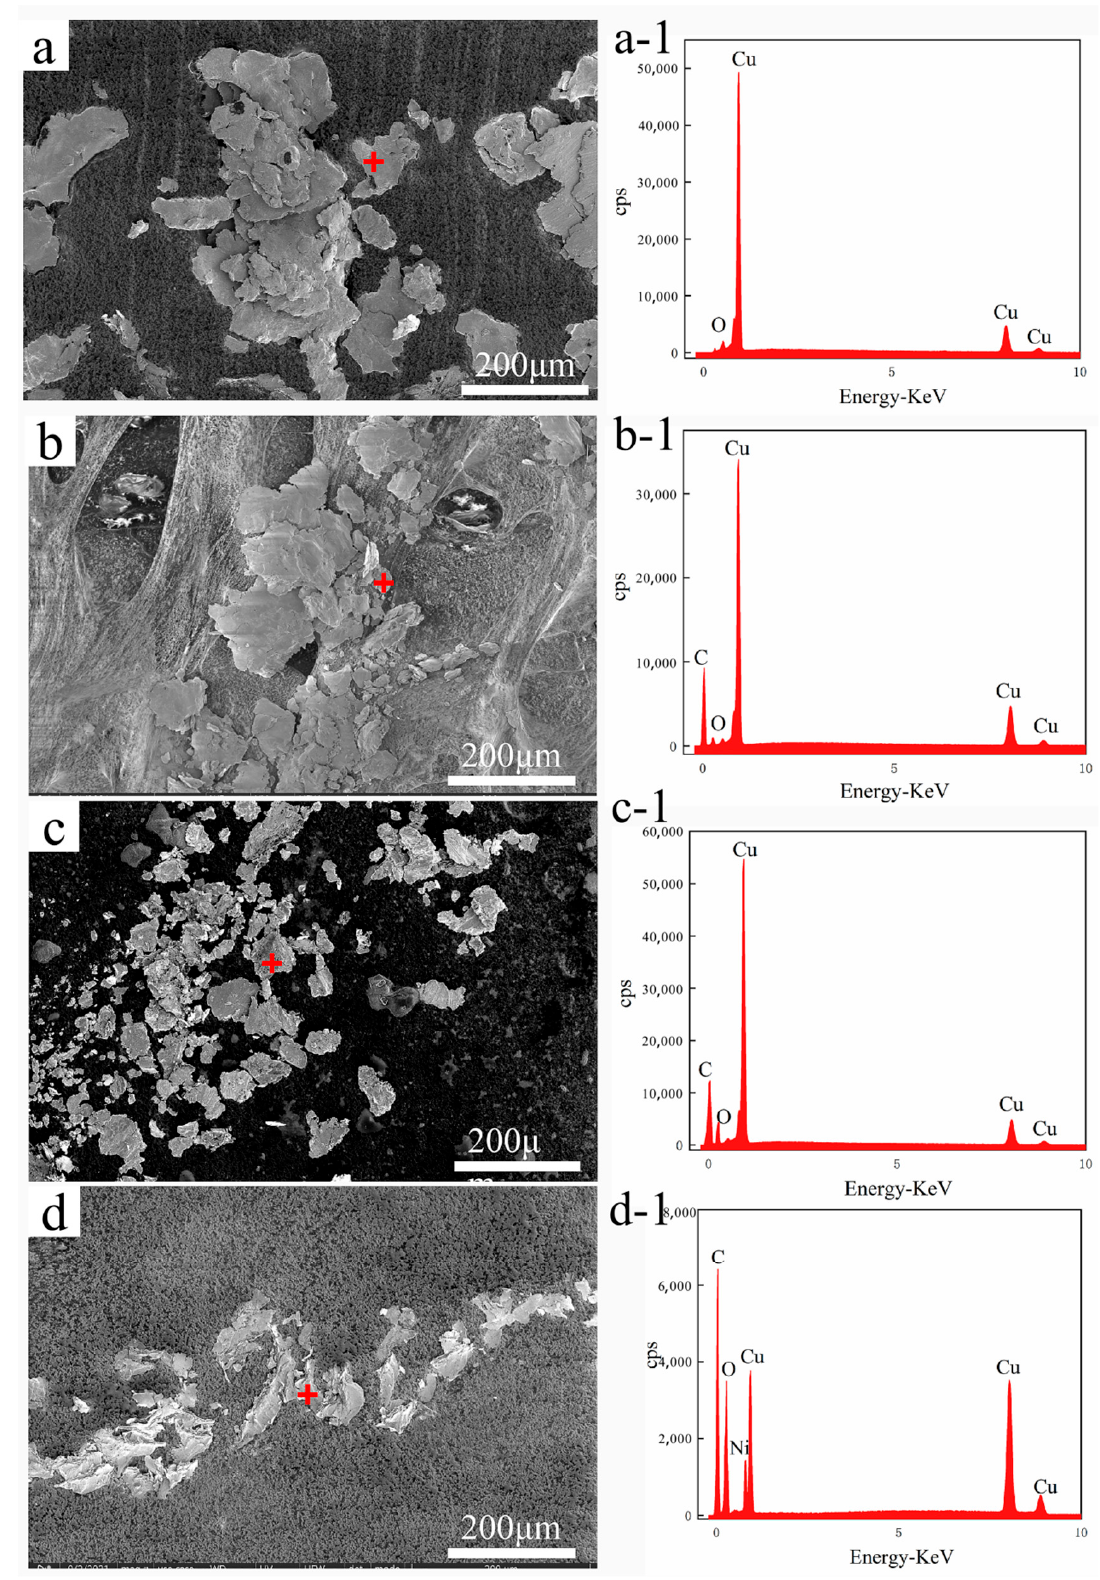
Figure 10. SEM micrograph and corresponding EDS of wear debris collected on the surface parallel to drawing direction of ( a , a-1 ) Pure Cu, ( b , b-1 ) B-MWCNTs/Cu composite, ( c , c-1 ) Cu@MWCNTs/Cu composite, ( d , d-1 ) Ni@MWCNTs/Cu composite.